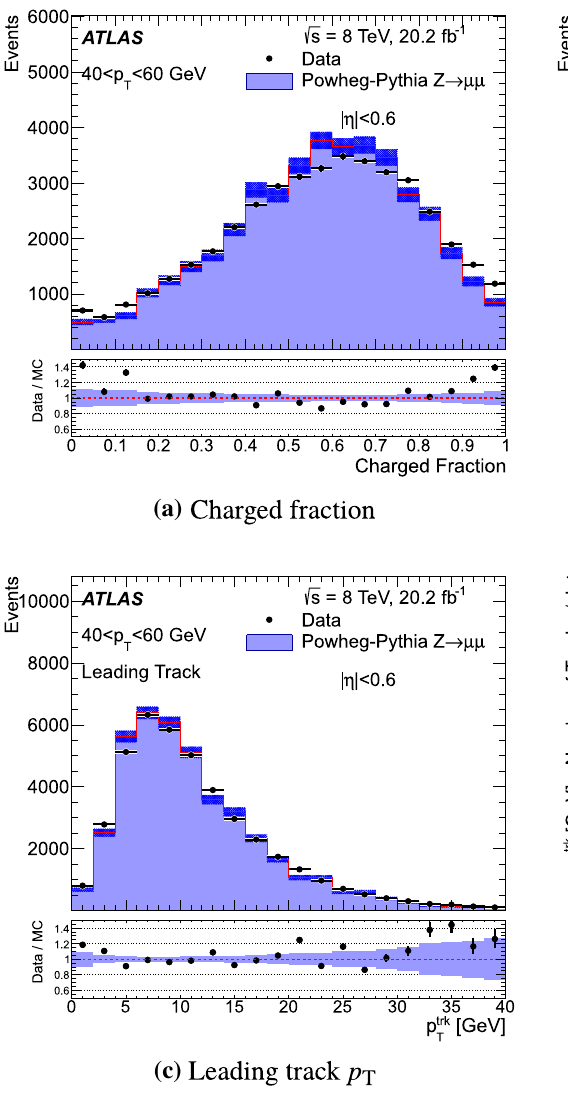
a 95% pure sample of t ¯ t events. The event E miss